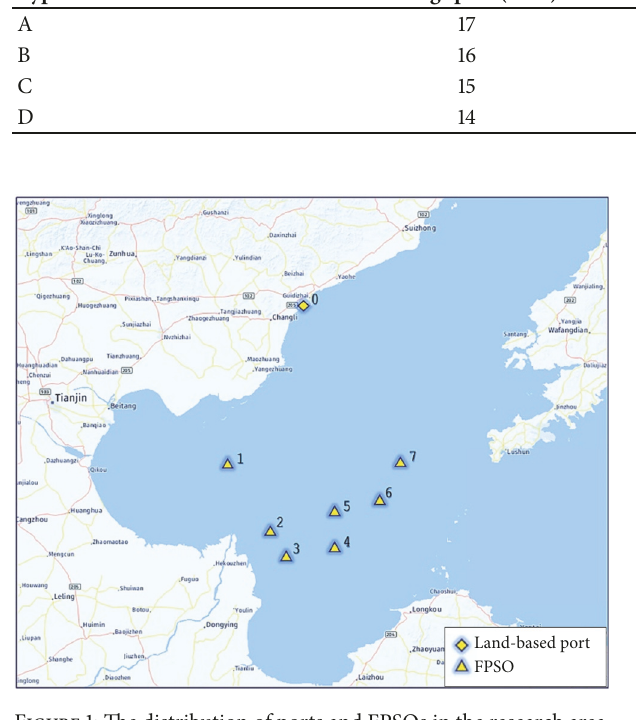
Figure 1: The distribution of ports and FPSOs in the research